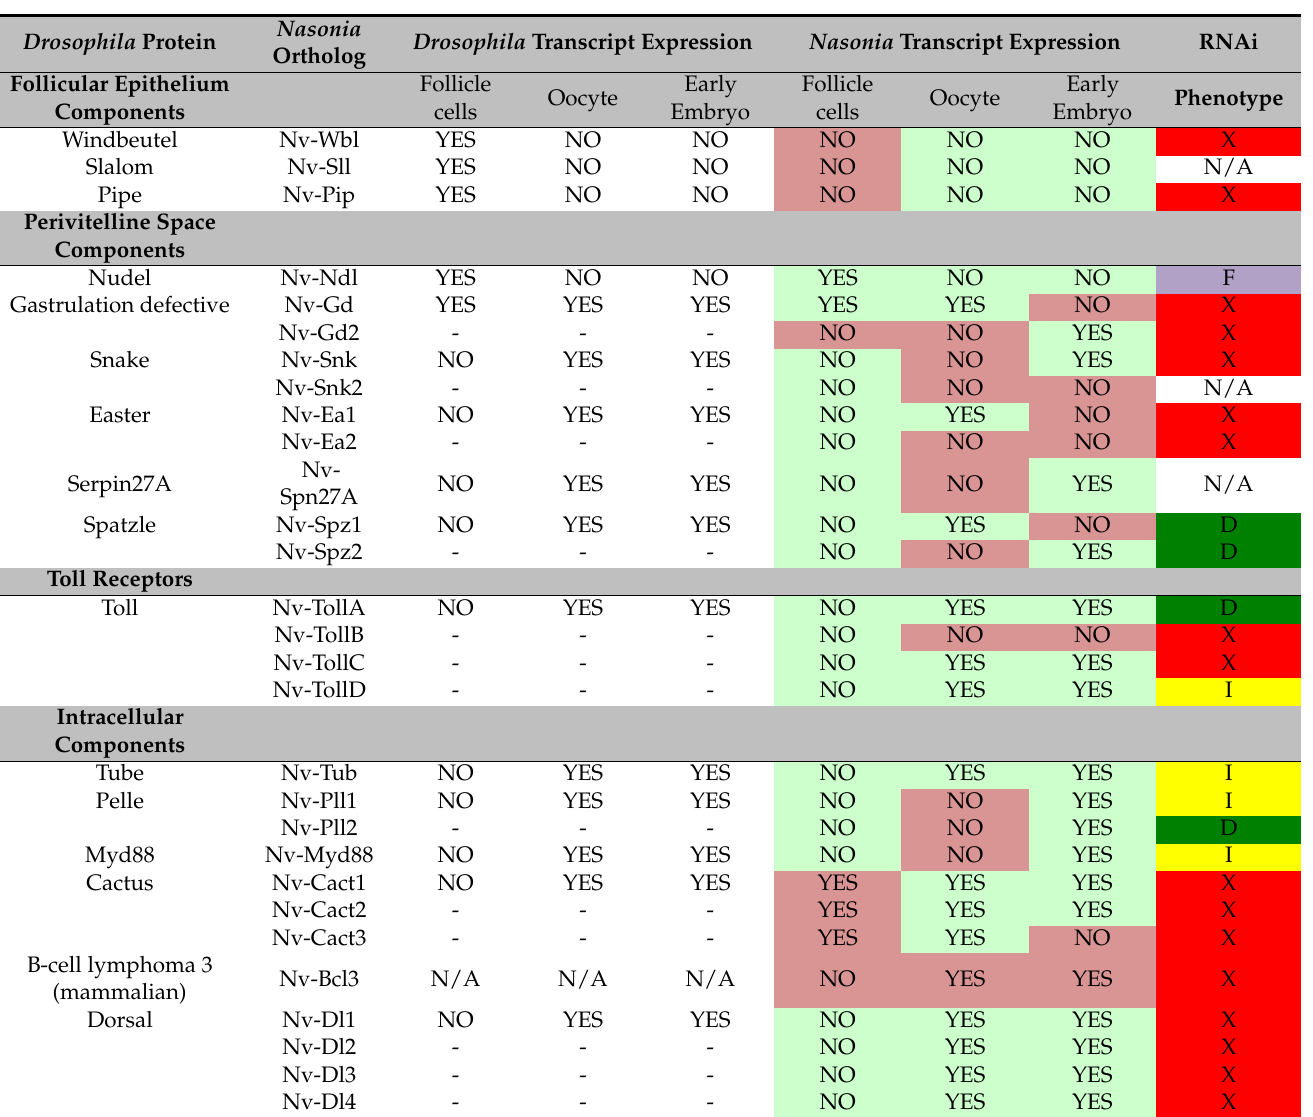
Table 1. Summary of Toll Pathway component expression in the fly and wasp. Tissue-based ex- pression domains in both the fly and wasp are provided for each pathway component based on previous [88–90] and current studies (color has been added to emphasize similarities/differences). RNAi phenotypes observed in the wasp include: X = no phenotype, D = dorsalized, I = immune/sick wasps, F = flaccid/fragile eggs, N/A = not